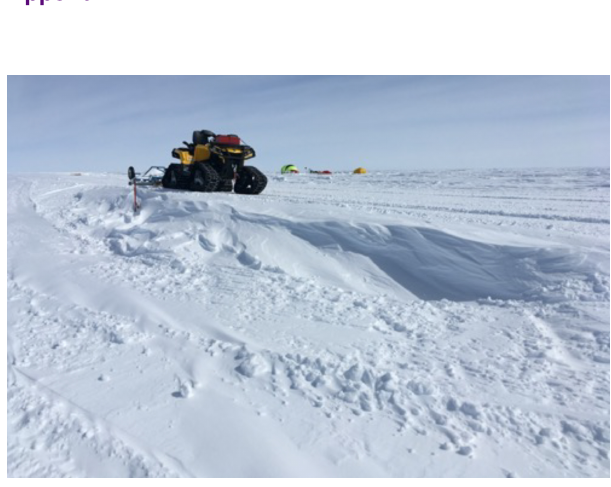
Figure A1. Sastrugi (as high as 0.5m) at Mount Brown South in East Antarctica during austral summer in 2017/2018. The height of the largest sastrugi is comparable with the annual mean snow accumulation rate over the period 1975–2016. Photo credit: Tessa Vance.